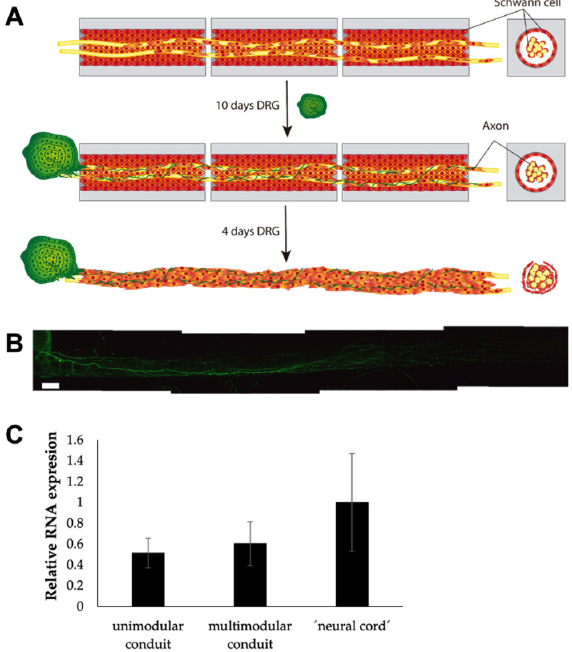
Figure 10. Axon growth in ‘neural cord’ after o-culture with dorsal root ganglion explant. ( A ) Longitudinal and transversal schematic view of obtention of the ‘neural cord’ and the co-culture with a dorsal root ganglion explant. ( B ) Representative confocal reconstruction of the first 4–5 mm of longitudinal sections of the ‘neural cord’ showing neuronal staining with Tuj 1 (green) after 10 days with HA conduits and 16 additional days without the HA conduits. ( C ) Analysis of relative mRNA expression of GAP43. Scale bar: 500 µ